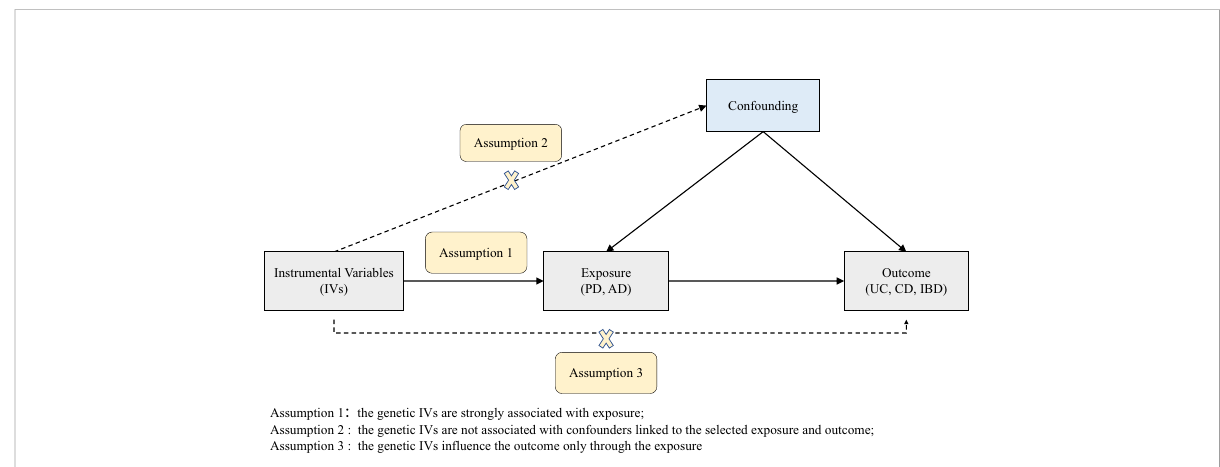
FIGURE 1 Diagram of the two-sample Mendelian randomization study for the associations of PD and AD with UC, CD, and IBD. PD, Parkinson ’ s disease; AD, Alzheimer ’ s disease; IBD, in fl ammatory bowel disease; UC, ulcerative colitis; CD, Crohn ’ s